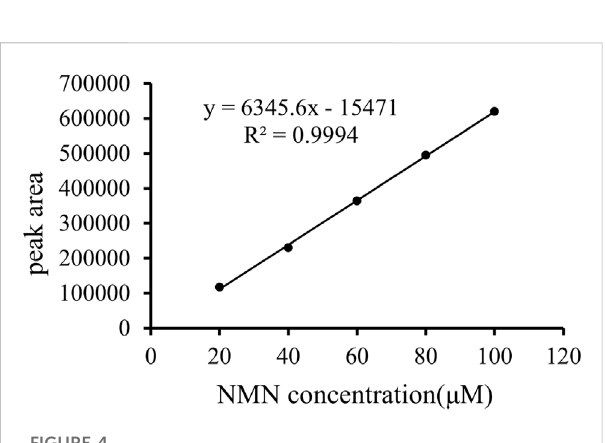
FIGURE 4 StandardcurveofNMN.Prepare100 μ MNMNstocksolutionand dilute it to standard solutions of 20 μ M, 40 μ M, 60 μ M, 80 μ M and 100 μ M respectively as standard koji of immobilized enzyme. The abscissa is the NMN standard concentration, and the ordinate is the peak area.